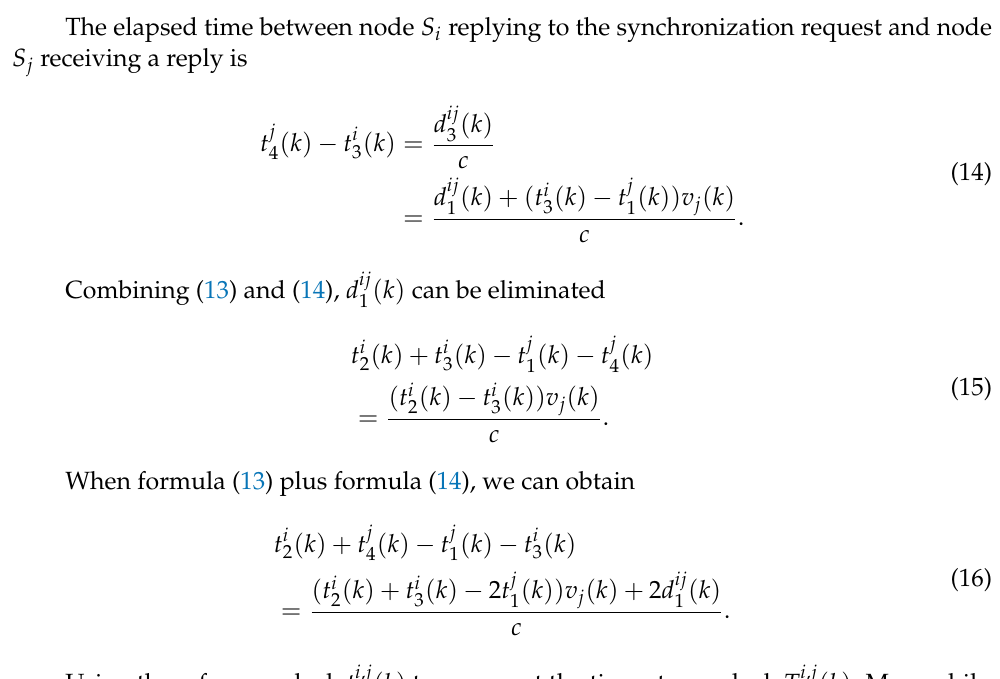
Figure 2. Distance representation in the k -th round-trip message exchanges